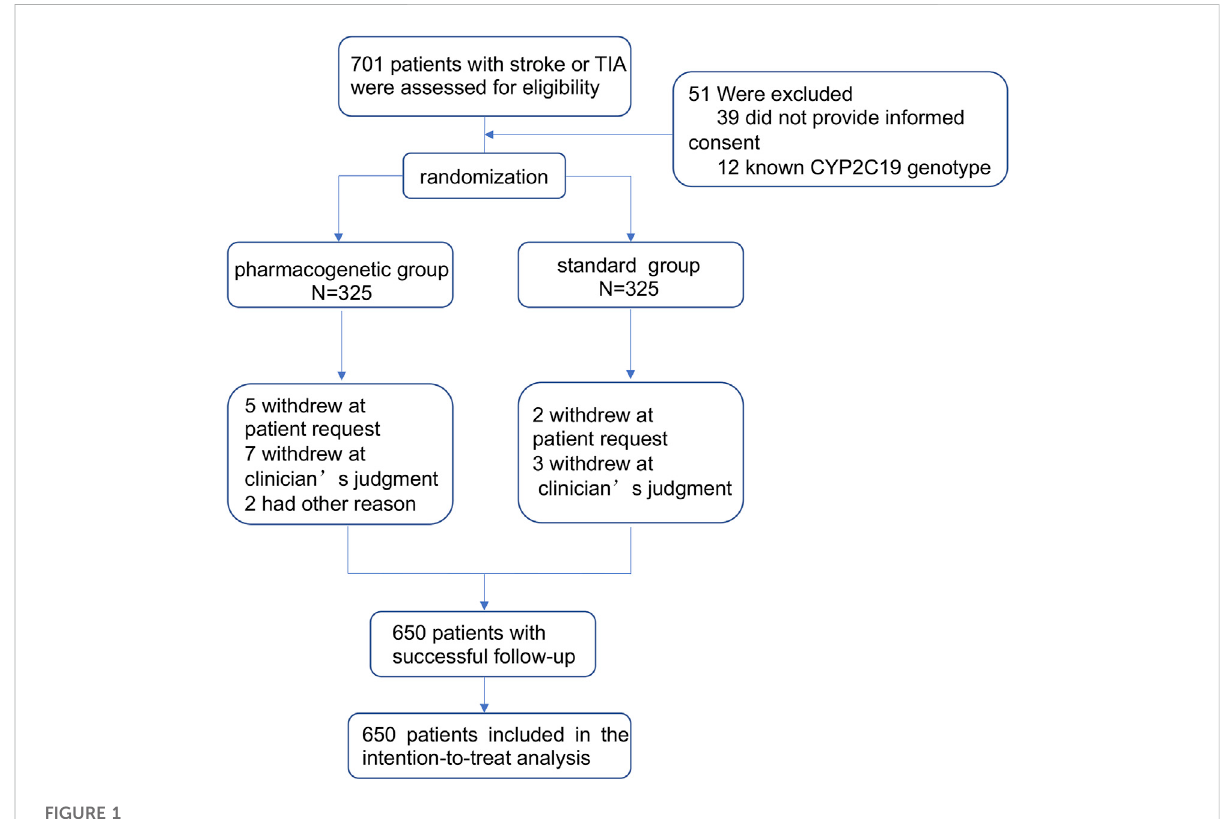
FIGURE 1 Trial pro fi